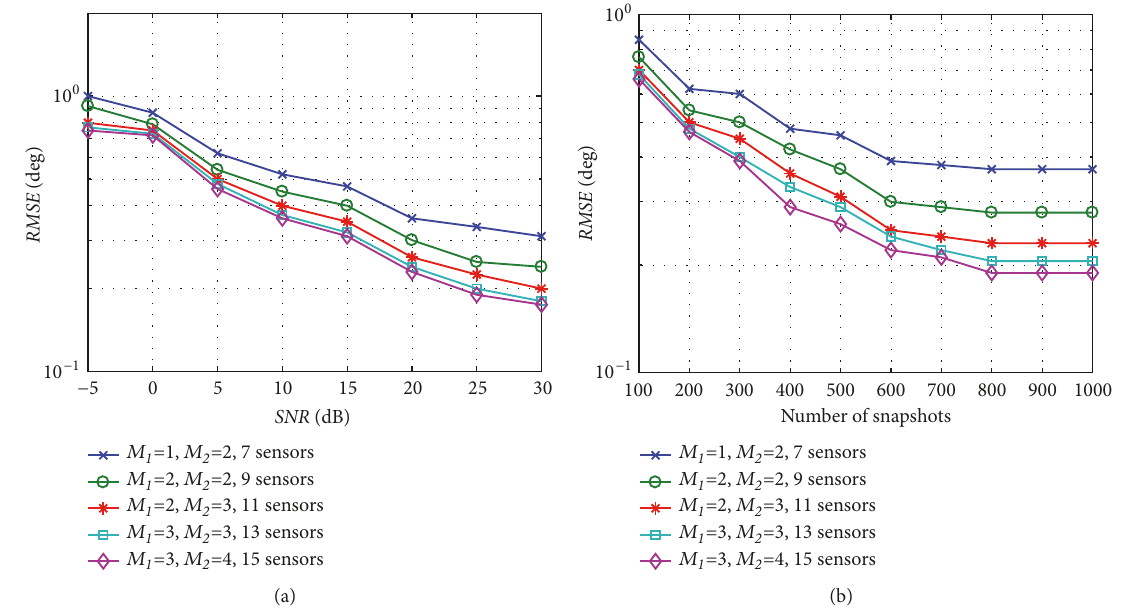
Figure 6: (a) RMSE estimated by different sensor number of subarrays versus SNR ; (b) RMSE estimated by different sensor number of subarrays versus number of